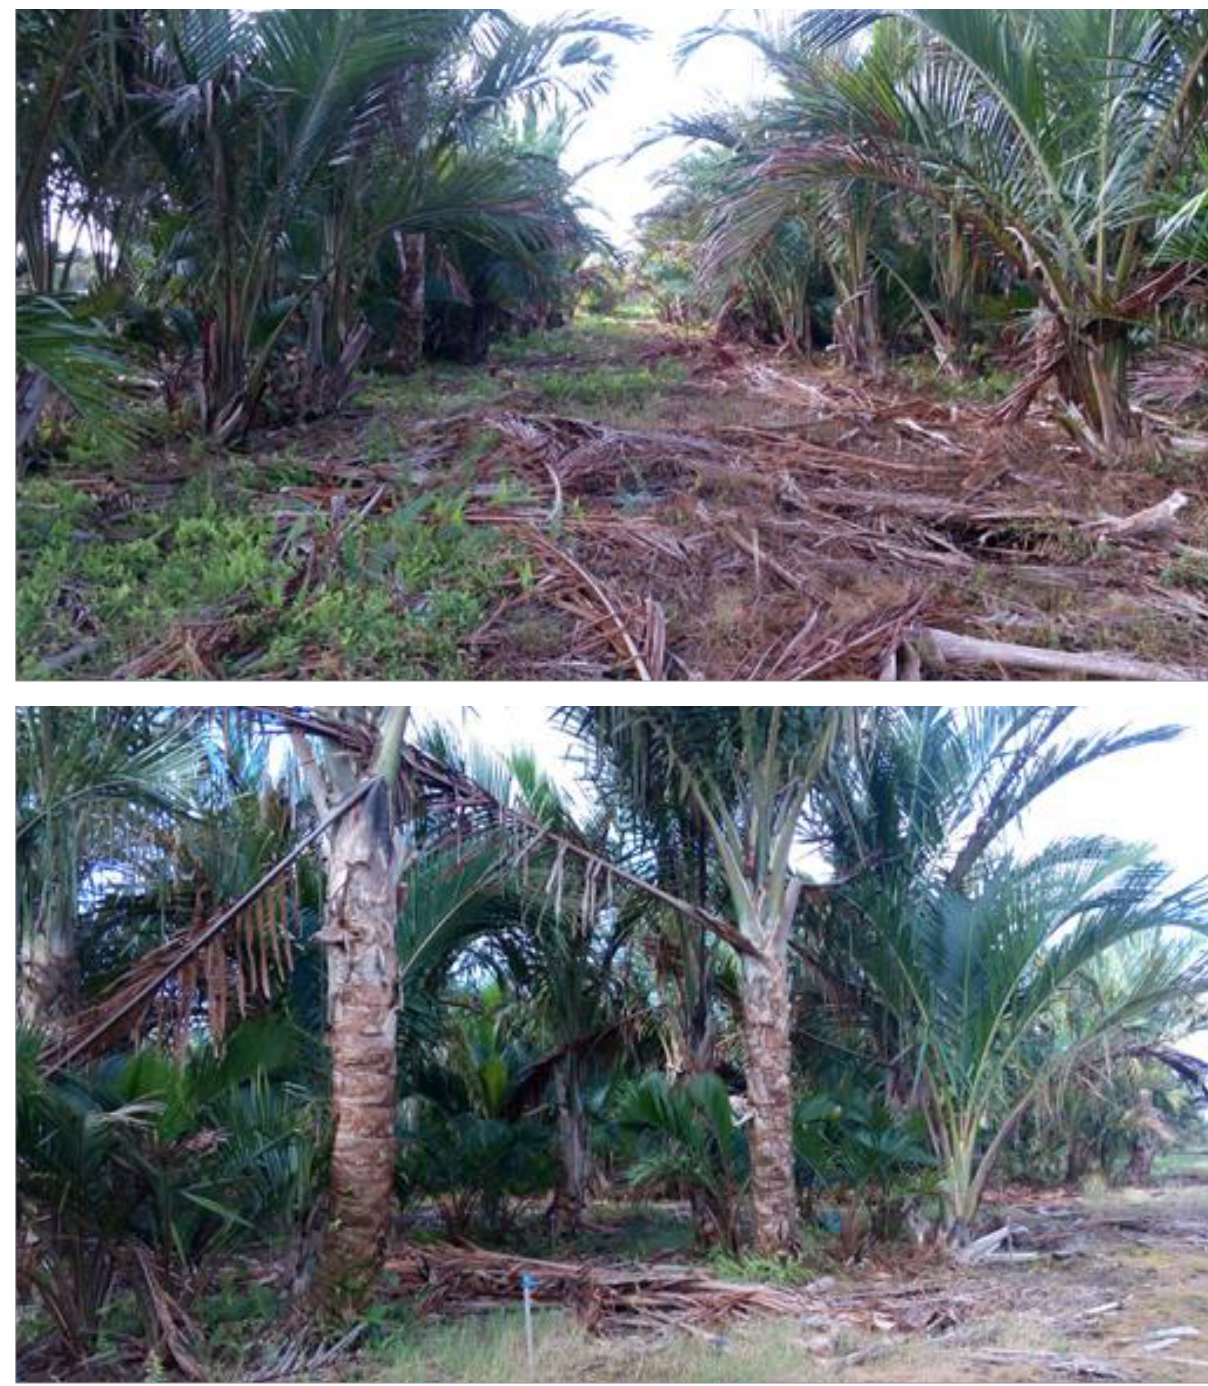
Figure 2. Photographs of non-trunking (above) and trunking (below) sago